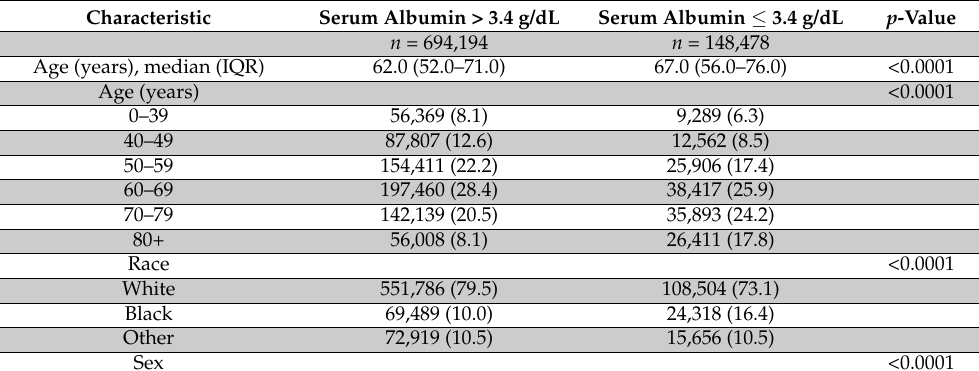
Table 2. Baseline Characteristics of Multidisciplinary Cohort Stratified by Preoperative Serum Albumin